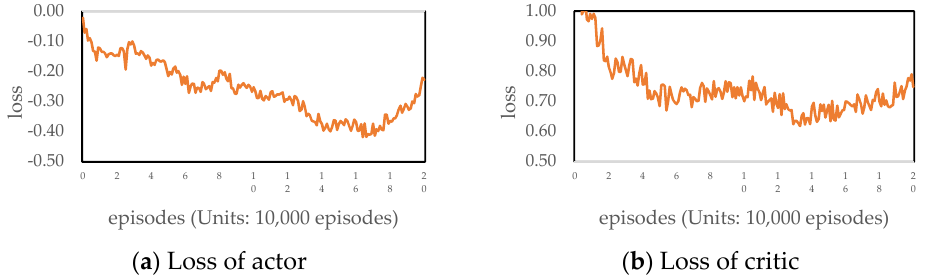
Figure 6. Change of loss depending on the number of learning using the proposed approach: ( a ) loss of actor, and ( b ) loss of critic. The x -axis is number of episodes (units: 10,000 episodes) and the y -axis is loss.